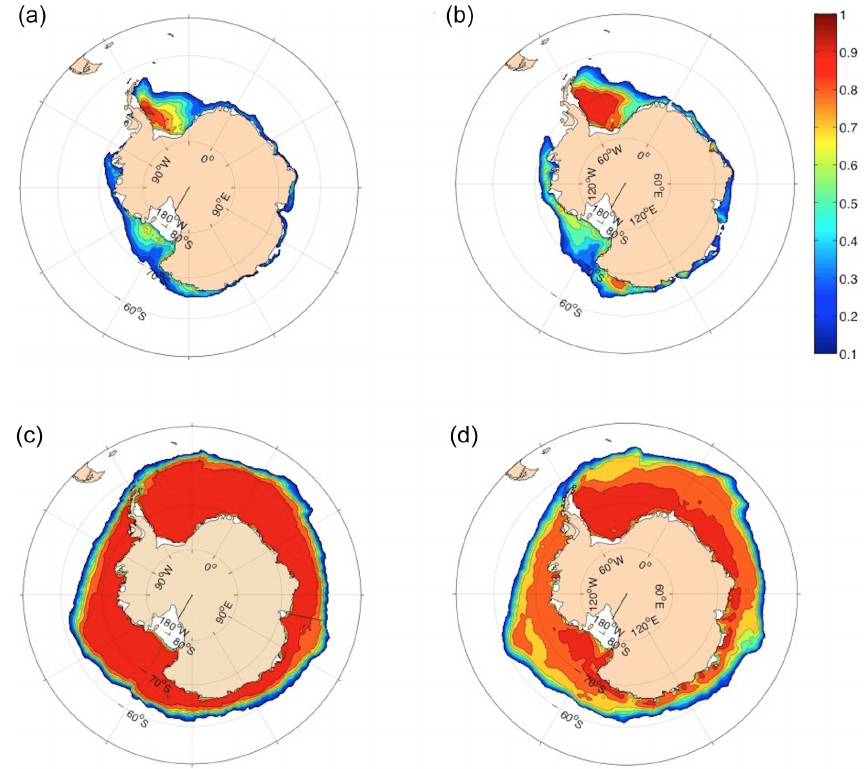
Figure 10. Maximum (a, b) and minimum (c, d) Antarctic sea ice concentration for the period 2009–2013 in GLOB16 (left) and observational data set